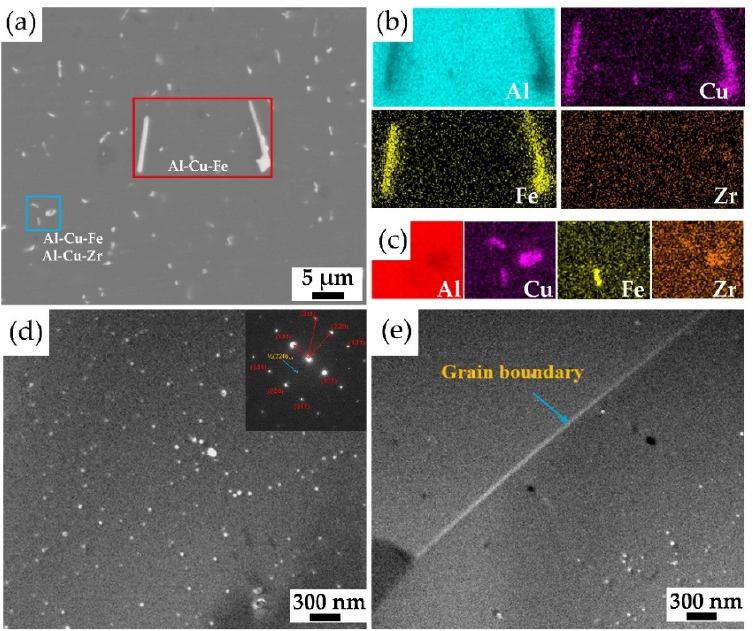
Figure 5. ( a ) SEM image of P2 homogenized alloy 2195; ( b ) and ( c ) EDS scan composition mappings of Al, Cu, Fe and Zr; ( d ) dark-fields TEM image of the β′ phase in one grain and the corresponding selected-area diffraction pattern (inserted); and ( e ) dark-field TEM image showing the β′ particles near grain boundary.